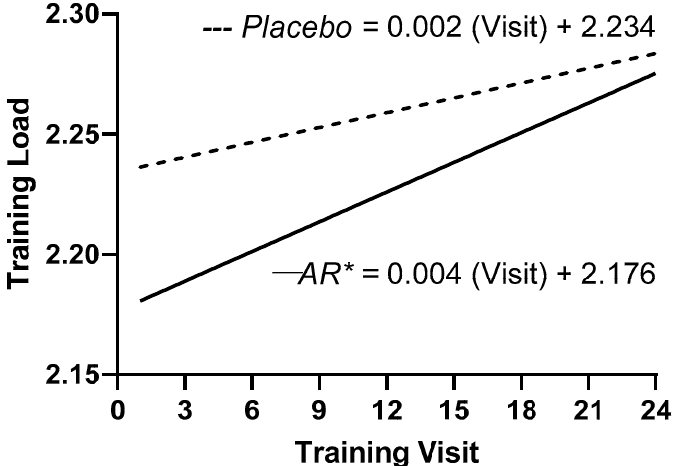
Figure 1. Regression analyses of the log-transformed training loads for the A. racemosus (AR) group ( ─ ) and the placebo group (---). * Indicates the slope coefficient for the A. racemosus group was significantly ( p < 0.001) greater than the placebo group.